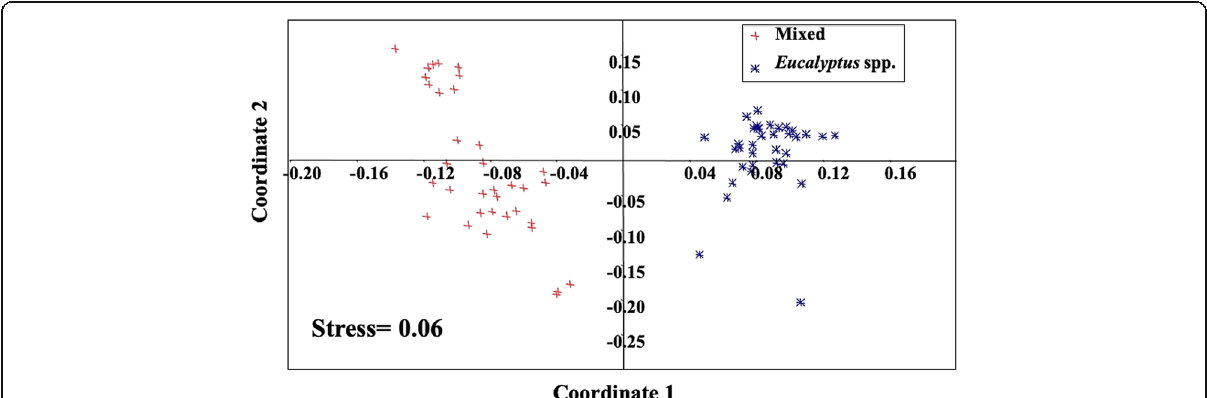
Fig. 6 Non-metric multidimensional scaling (NMDS) diagram plotting the order of macro- and micronutrients and litter origin. The stress value is the distortion between the original data and data plotted in the diagram. Statistical inference of dissimilarity between the groups was obtained by one-way analysis of similarities (ANOSIM) considering a p -value ≤